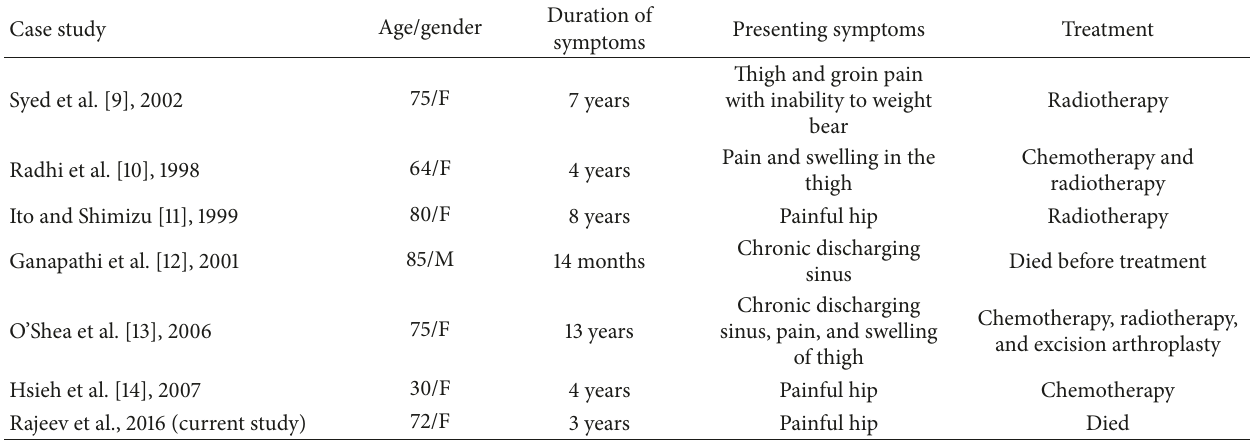
Table 1: Case studies with diffuse B cell NHL after total hip